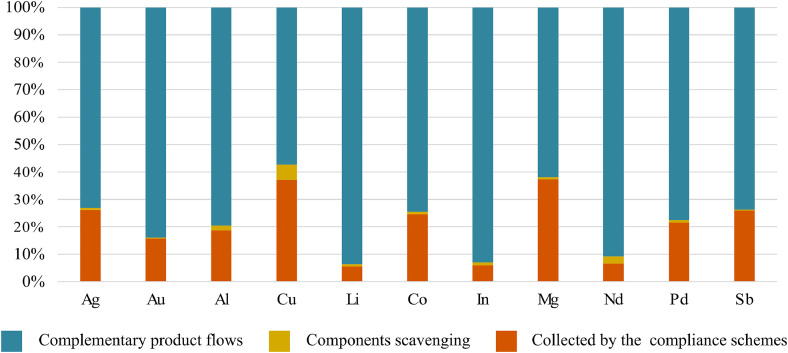
WEEE category II in France: target element generated (2017).